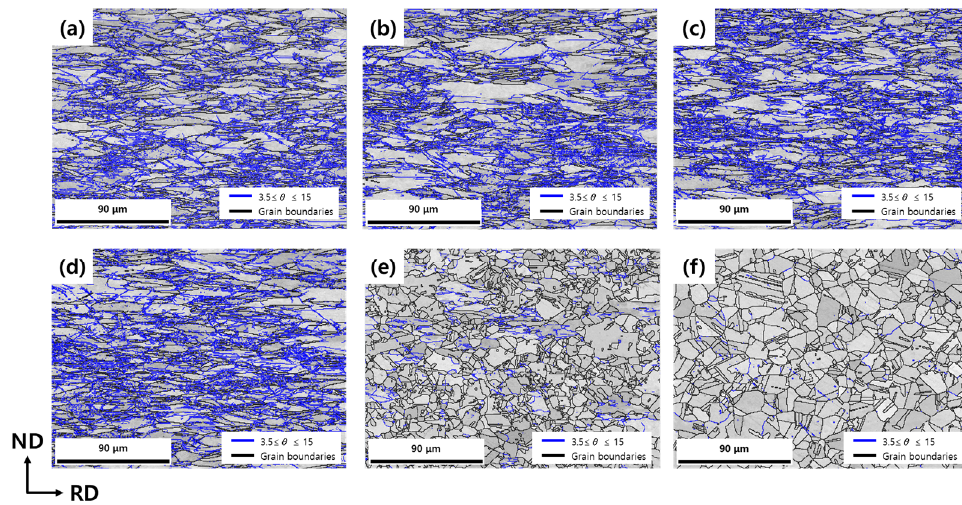
Figure 2. Low angle boundary and grain boundary map of the ( a ) cold-rolled, ( b ) 400 °C, ( c ) 500 °C, ( d ) 700 °C, ( e ) 800 °C, and ( f ) 900 °C heat treated specimens.